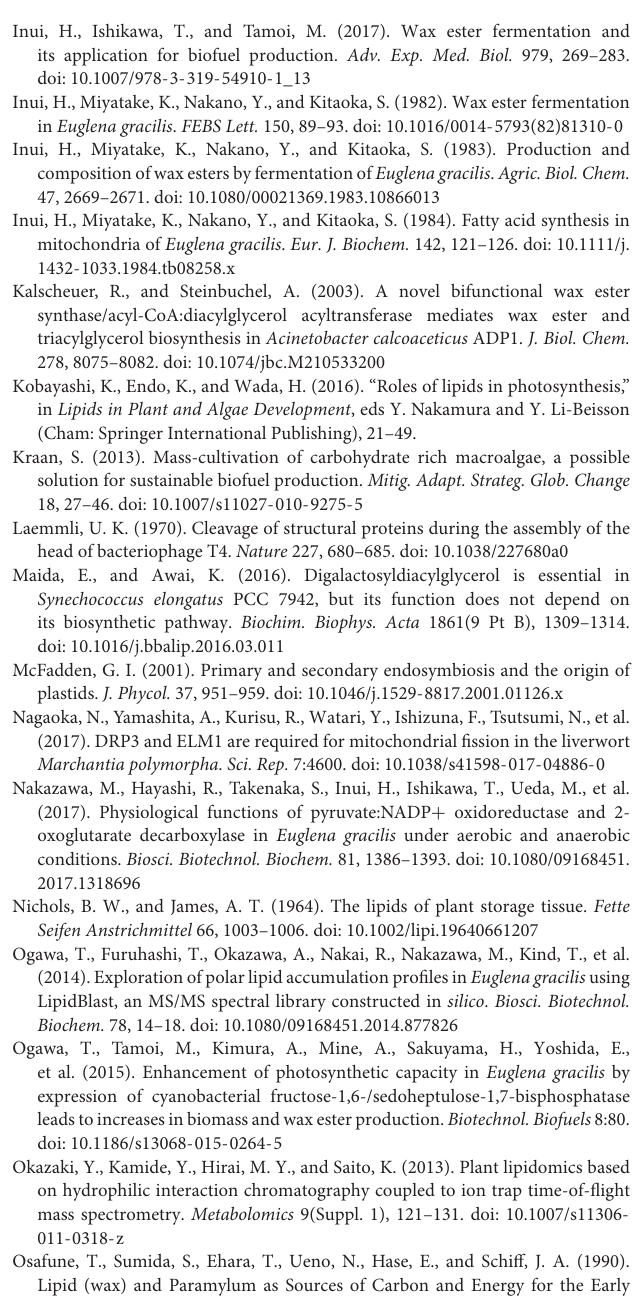
FIGURE S1 | SDS-PAGE of E . gracilis proteins. Proteins were extracted from cells grown under photoautotrophic, photomixotrophic and heterotrophic conditions and subjected to SDS-PAGE followed by CBB staining. Lane 1, CM conditions; lane 2, CM + Glc conditions; lane 3, Dark conditions. M: molecular weight marker (Nacalai Tesque,